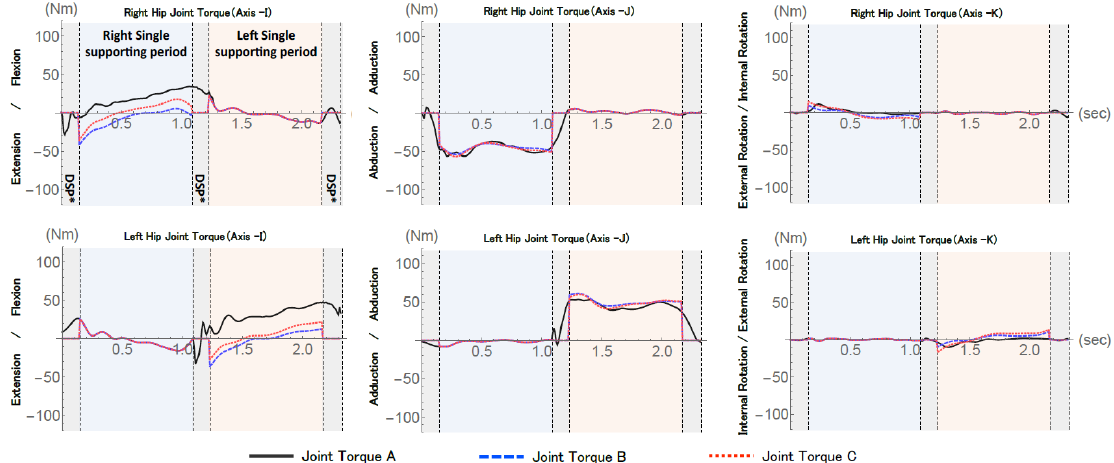
Figure 3. Comparison of Hip joint torque. * DSP: Double supporting period.